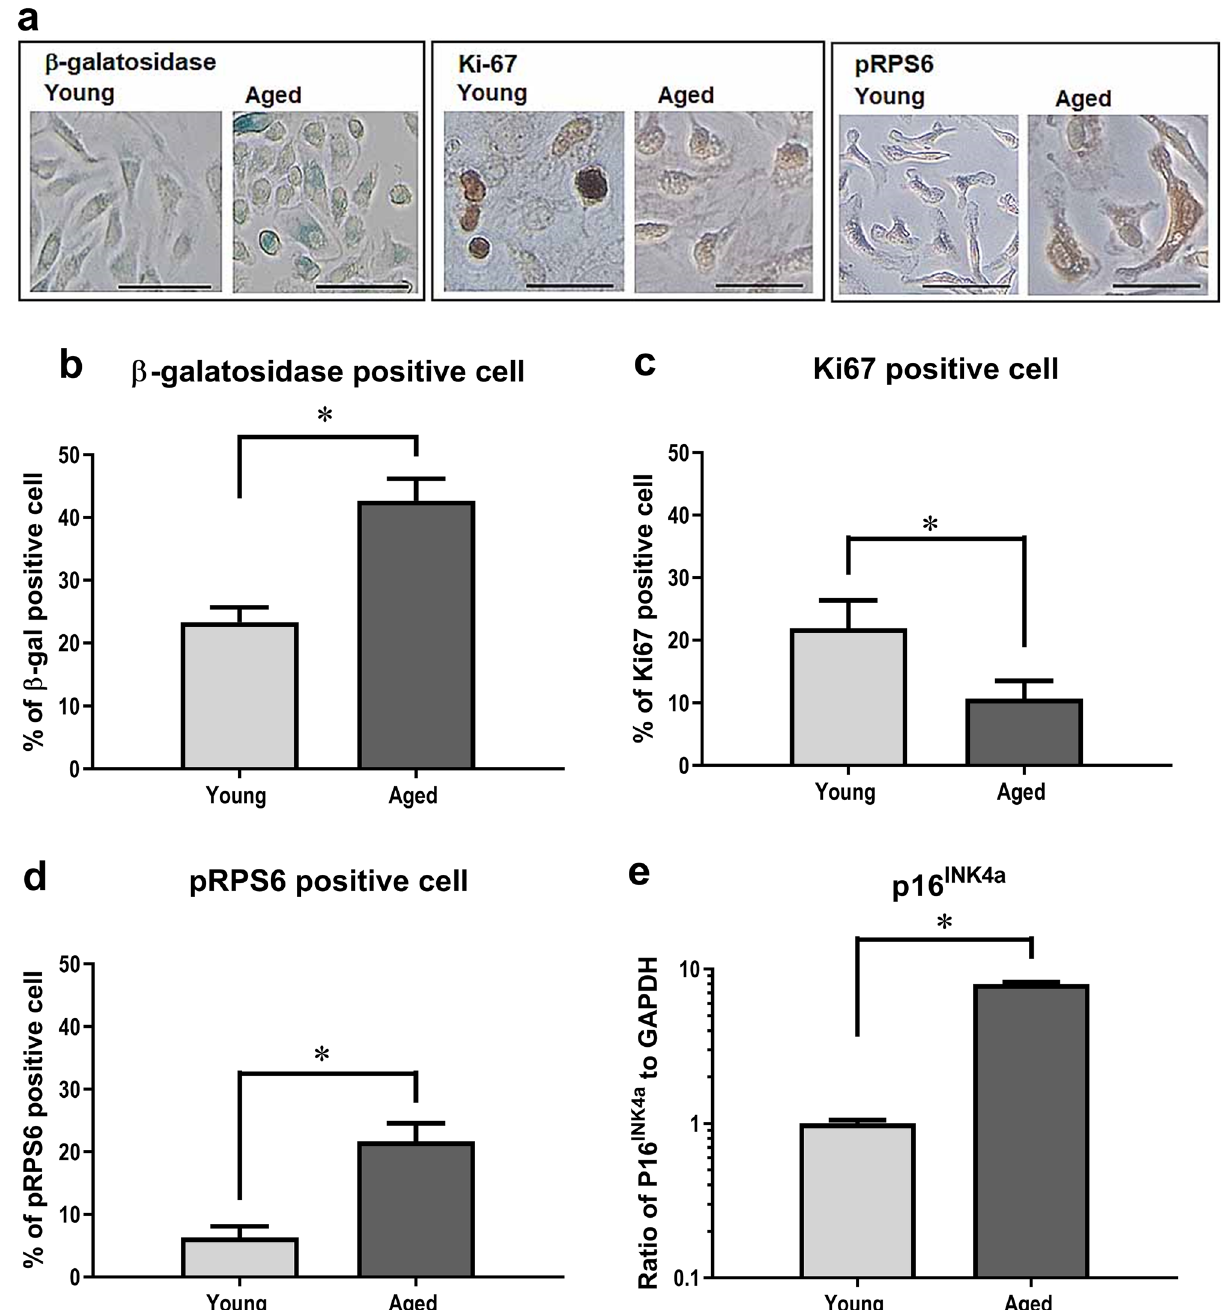
Figure 7. Age-related qualitative changes in BM stromal cells. ( a ) Images of cultured stromal cells obtained from young and aged SAMP1/TA-1 mice. β-galactosidase-positive cells are indicated by blue staining. Ki67- positive cells were identified by brown staining in nuclei, and pRPS6-positive cells were identified by brown staining in the cytoplasm. Scale bar, 50 µm. The bar graph shows proportions of β-galactosidase-positive cells from ( b ), Ki-67-positive cells from ( c ), and pRPS6-positive cells from ( d ). ( e ) Levels of p16 INK4a -encoding transcripts in cultured stromal cells obtained from young and aged SAMP1/TA-1 mice. The values in aged mice are normalized to the level in young mice, which was arbitrarily set to a value of 1. Each bar represents the mean ± SD obtained from three culture wells. *P <